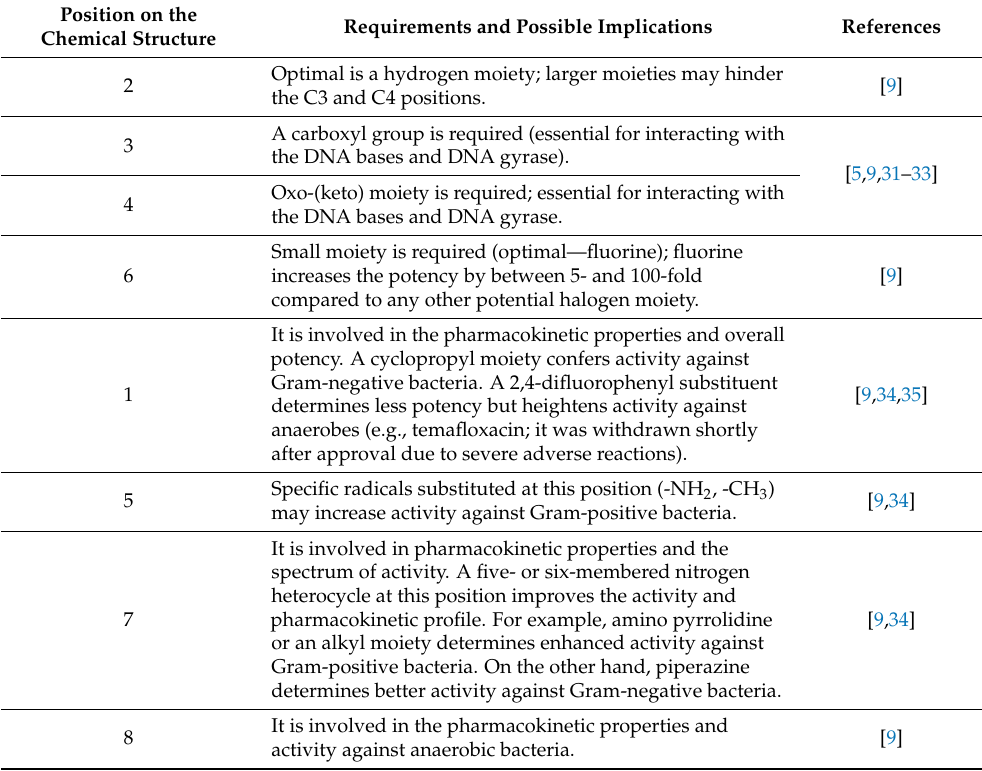
Table 1. Essential structure–activity relationship aspects in the antibacterial QNs class. Position on the Chemical